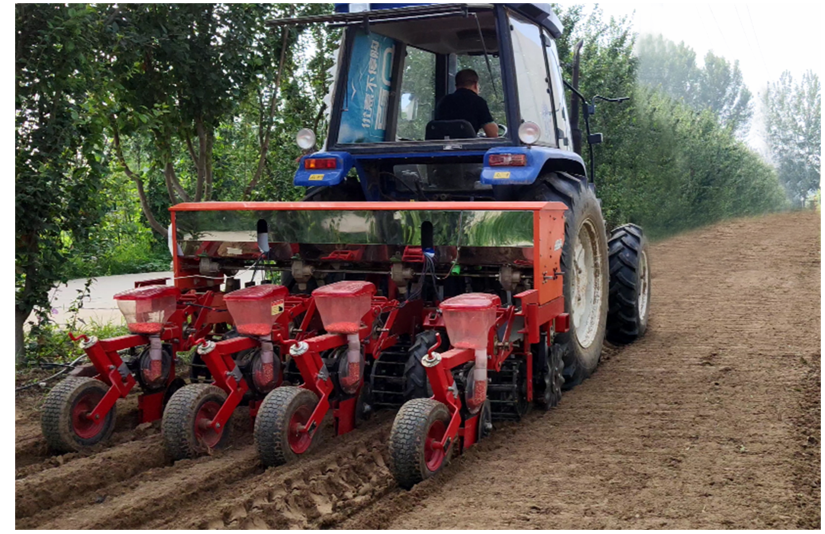
Figure 6. Field performance experiment of corn hill-drop fertilizer